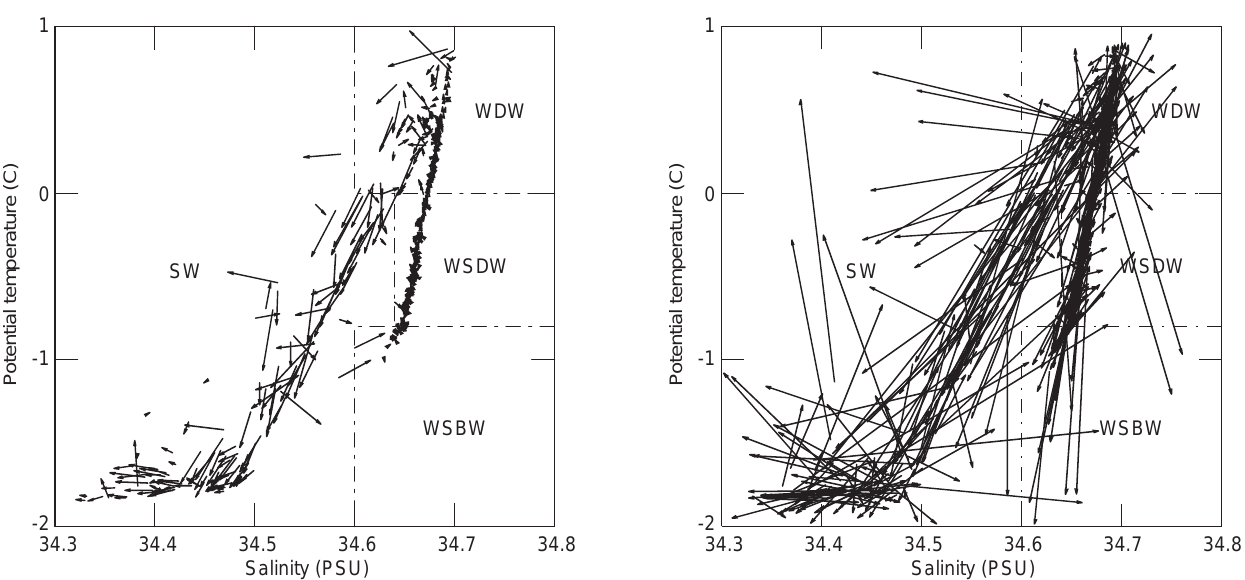
Fig. 5a,b. ‘‘Vector’’ (cid:104) – S diagrams derived a from the assimilation solution and b the first guess model state of the composite data set. Arrows denote annual mean displacements of the water parcels in the absence of advection. Parcels, leaving the plot area in b are not